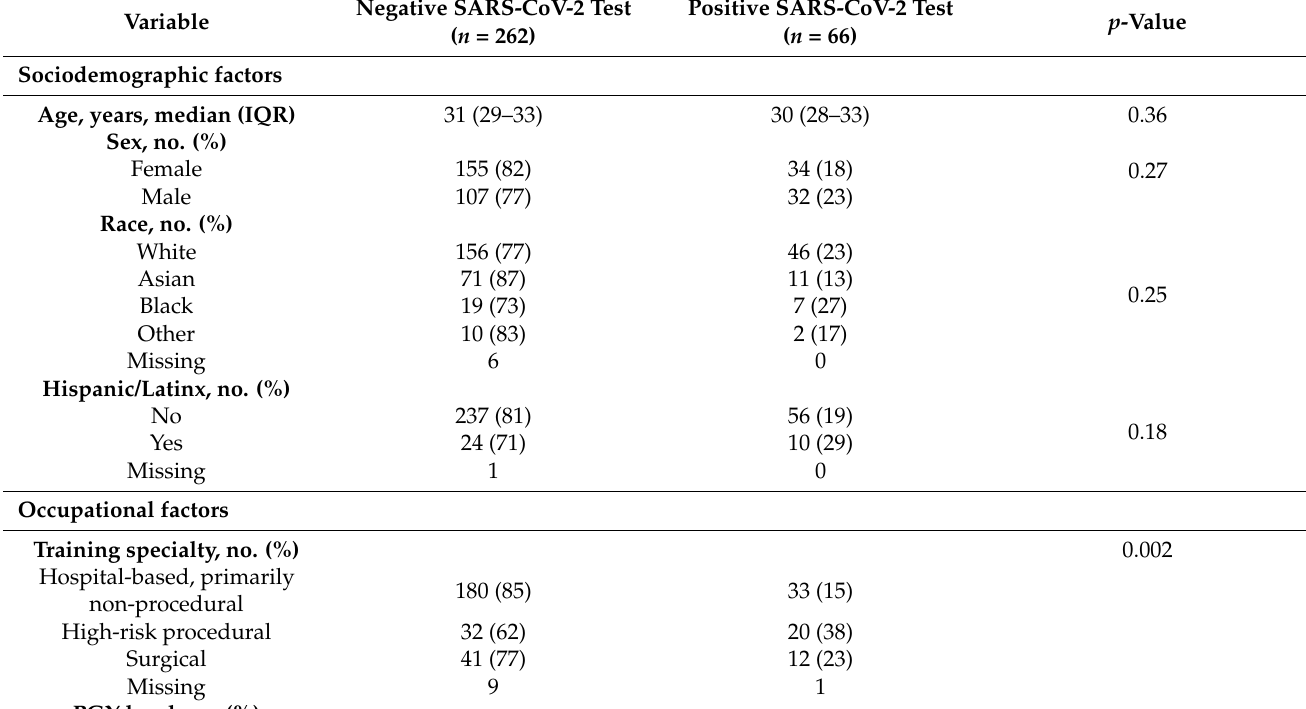
Table 1. Sociodemographic, occupational and community risk factors by SARS-CoV-2 test status.